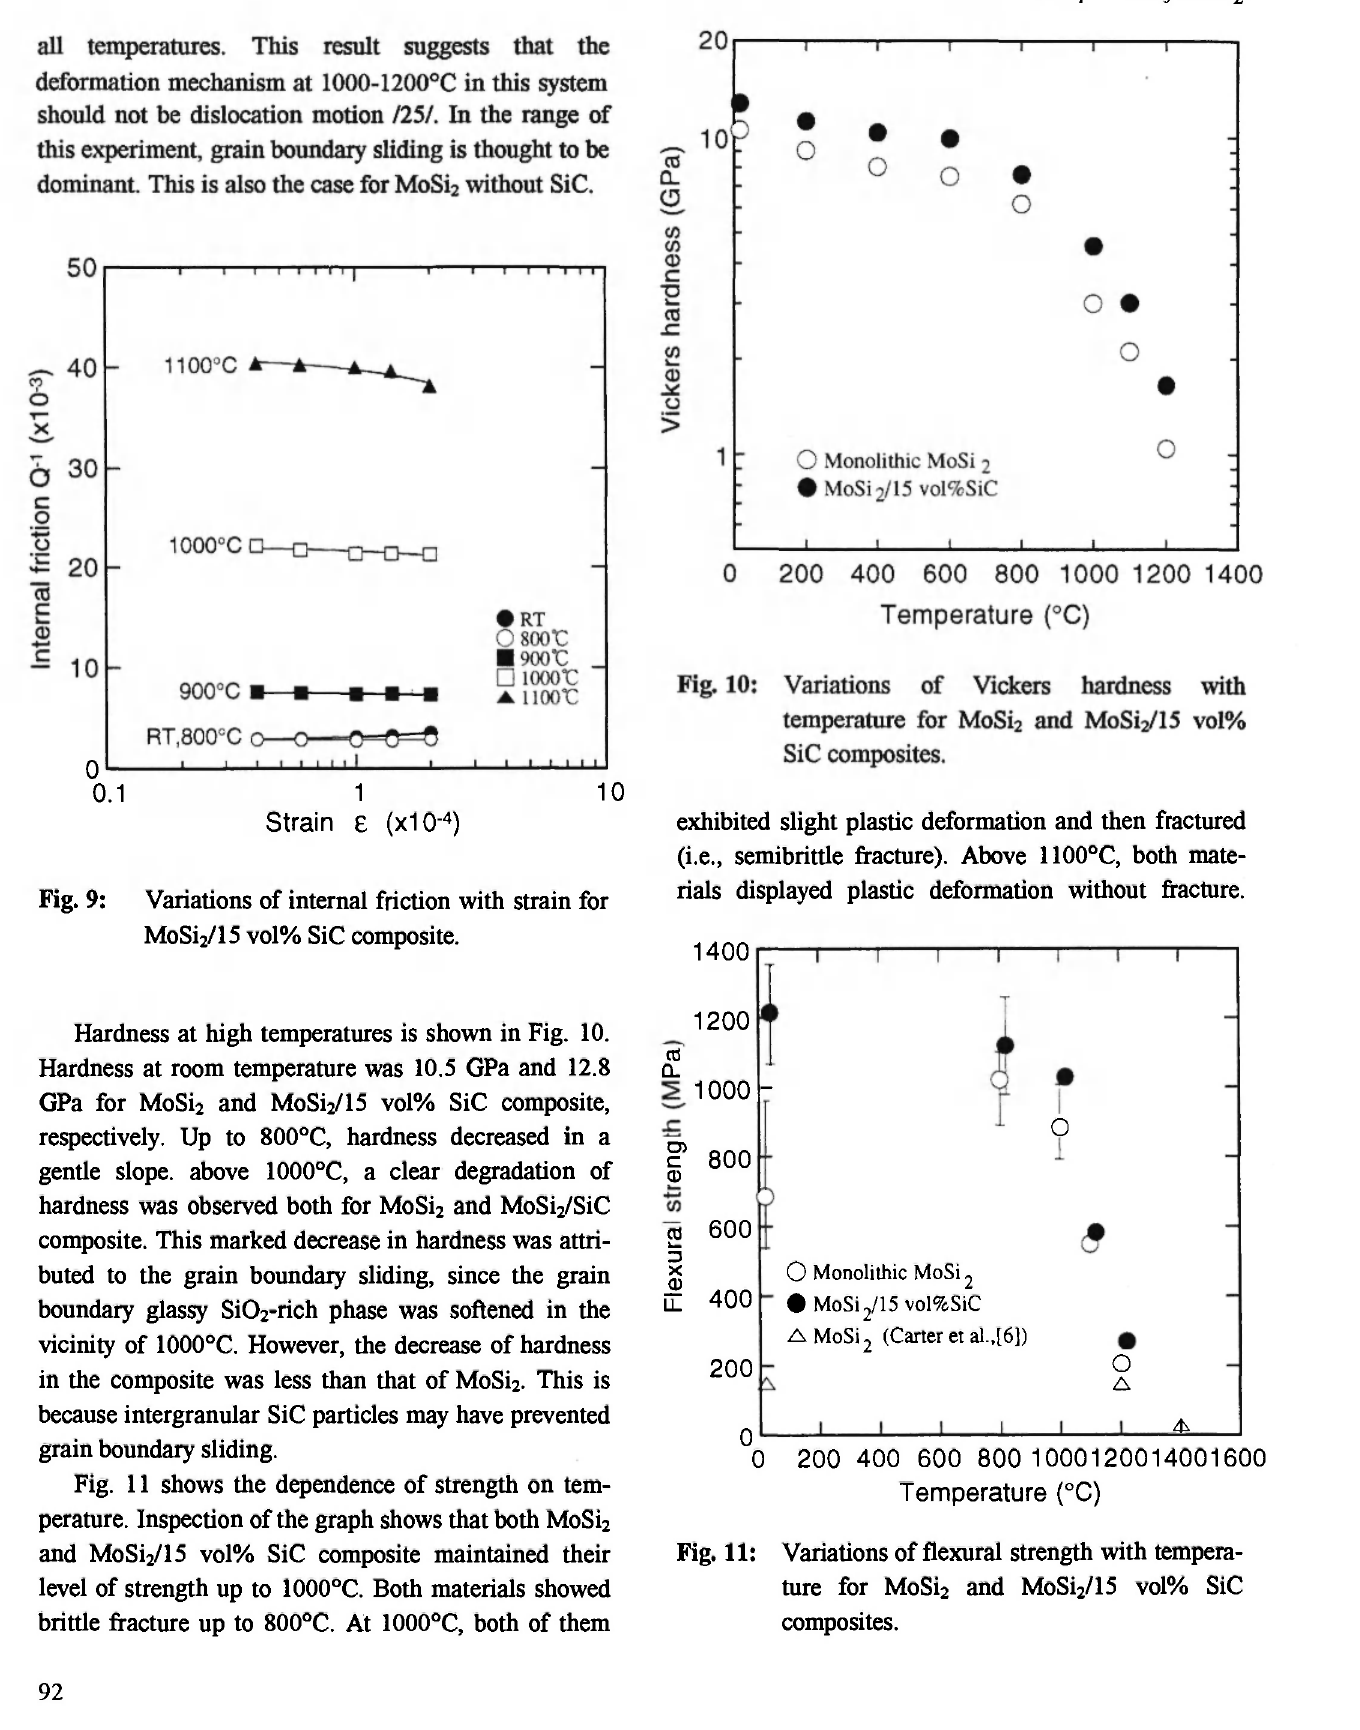
Fig. 11: Variations of flexural strength with tempera- ture for MoSi